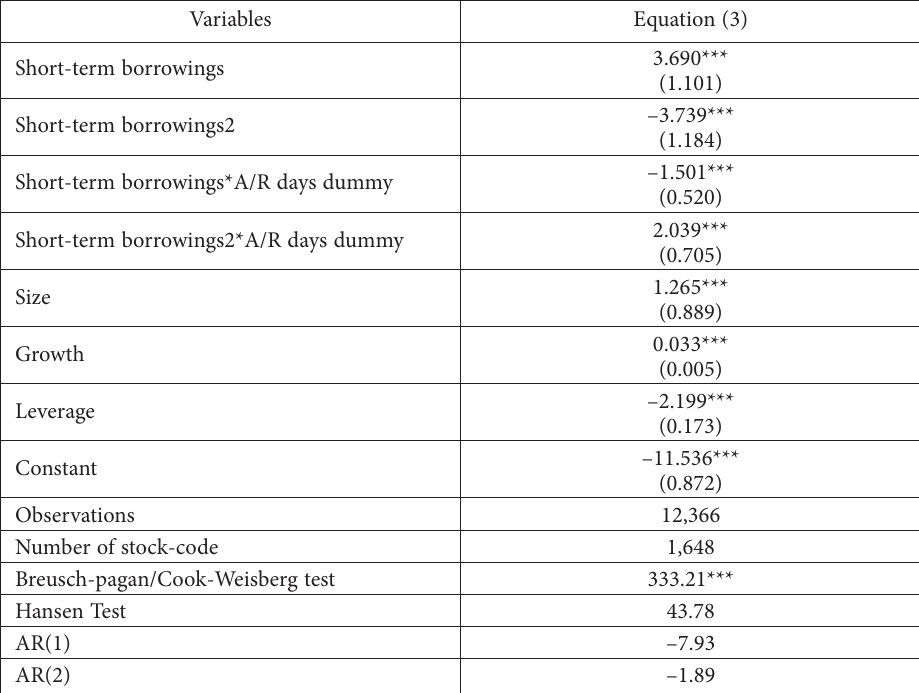
Table 5. Short-term borrowings and Profitability for firms having reduced and extended account re- ceivable days